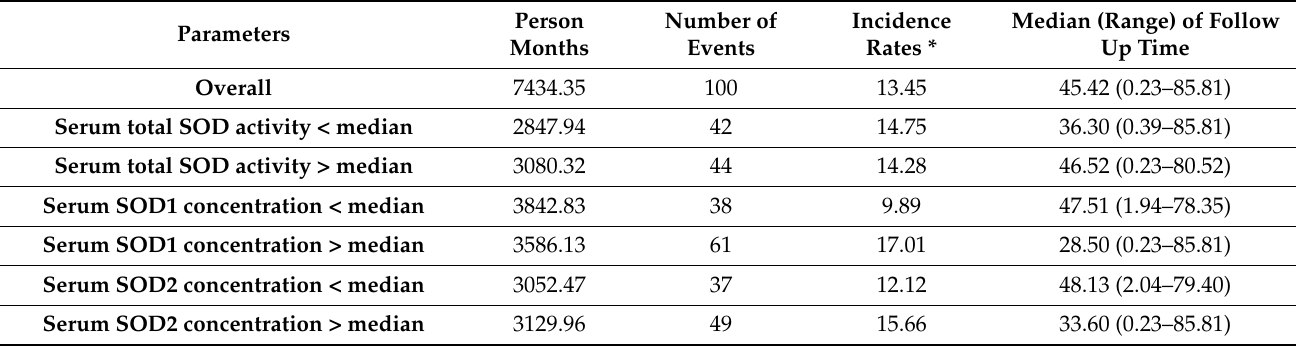
Table 5. Follow-up times and incidence of all-cause death in lung cancer patients by serum SOD total activity and serum SOD1 and SOD2